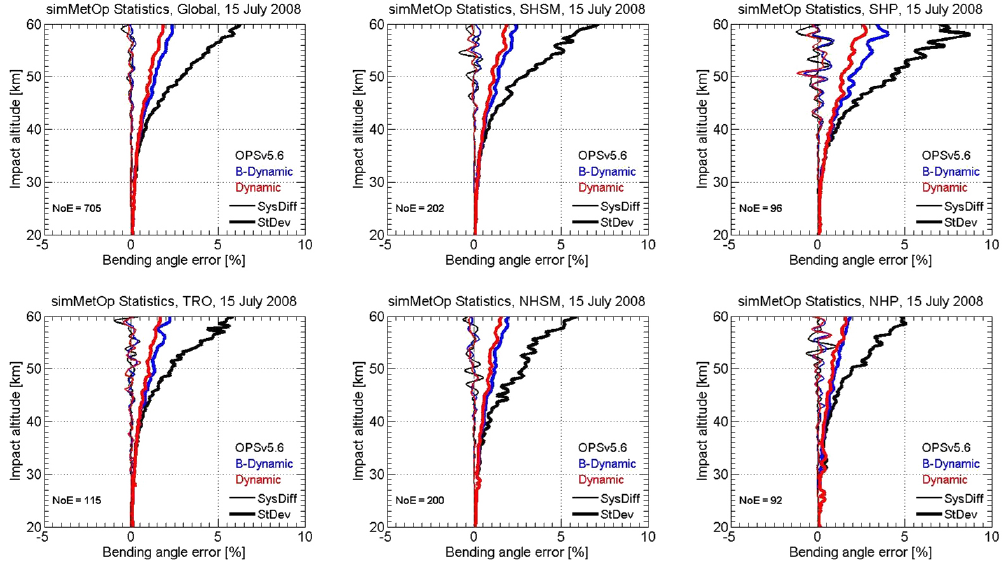
Figure 10. Systematic differences (SysDiff, light lines) and standard deviations (SD, heavy lines) of statistically optimized bending angles, relative to “perfect” simulated bending angles used as a reference, of simMetOp events on 15 July 2008. Statistics for the OPSv5.6 (black), b-dynamic (blue), and dynamic (red) statistical optimization algorithms are shown for six different regions: Global (90 ◦ S to 90 ◦ N), TRO (tropics, 20 ◦ S to 20 ◦ N), SHSM (Southern Hemisphere subtropics and midlatitudes, 20 to 60 ◦ S), NHSM (Northern Hemisphere subtropics and midlatitudes, 20 to 60 ◦ N), SHP (Southern Hemisphere polar region, 60 to 90 ◦ S), and NHP (Northern Hemisphere polar region, 60 to 90 ◦ N). The number of events (NoE) used in the ensemble of each region is also indicated in the